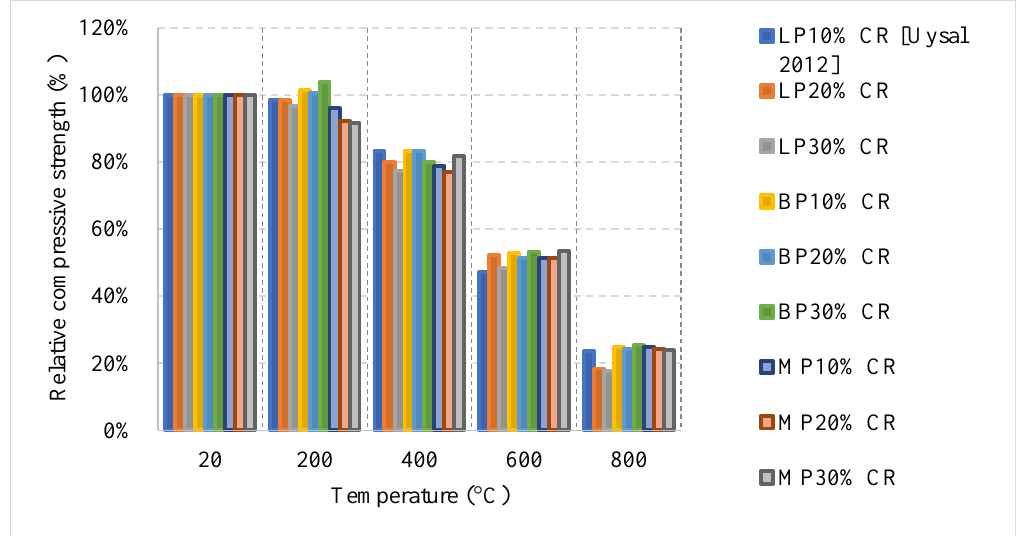
Figure 32. Relative compressive strength of furnace cooled SCC with different constituents 2. LP: Limestone powder, BP: Basalt powder, MP: Marble powder, CR: Cement Replacement [106].